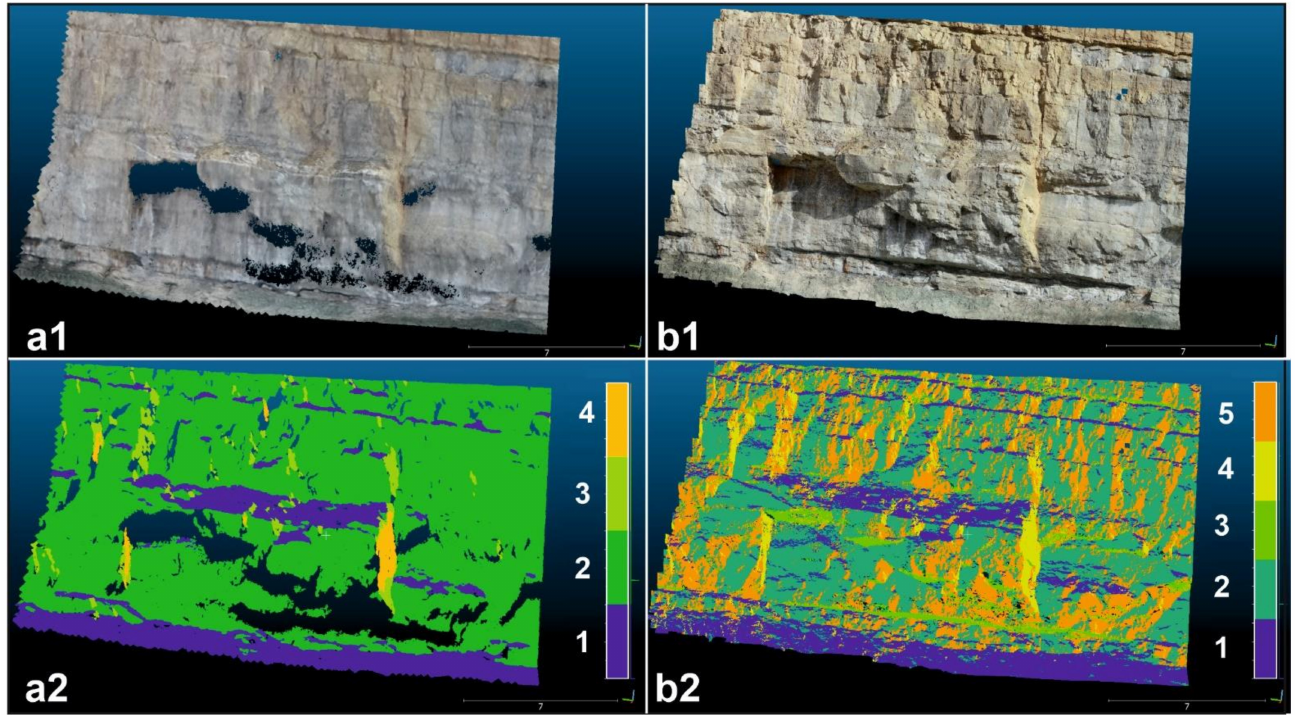
Figure 11. Detail of the point clouds ( 1 ) and discontinuity clusters ( 2 ) in two drone settings: AMSL-40 ◦ -off-nadir ( a ) and facade-nadir ( b